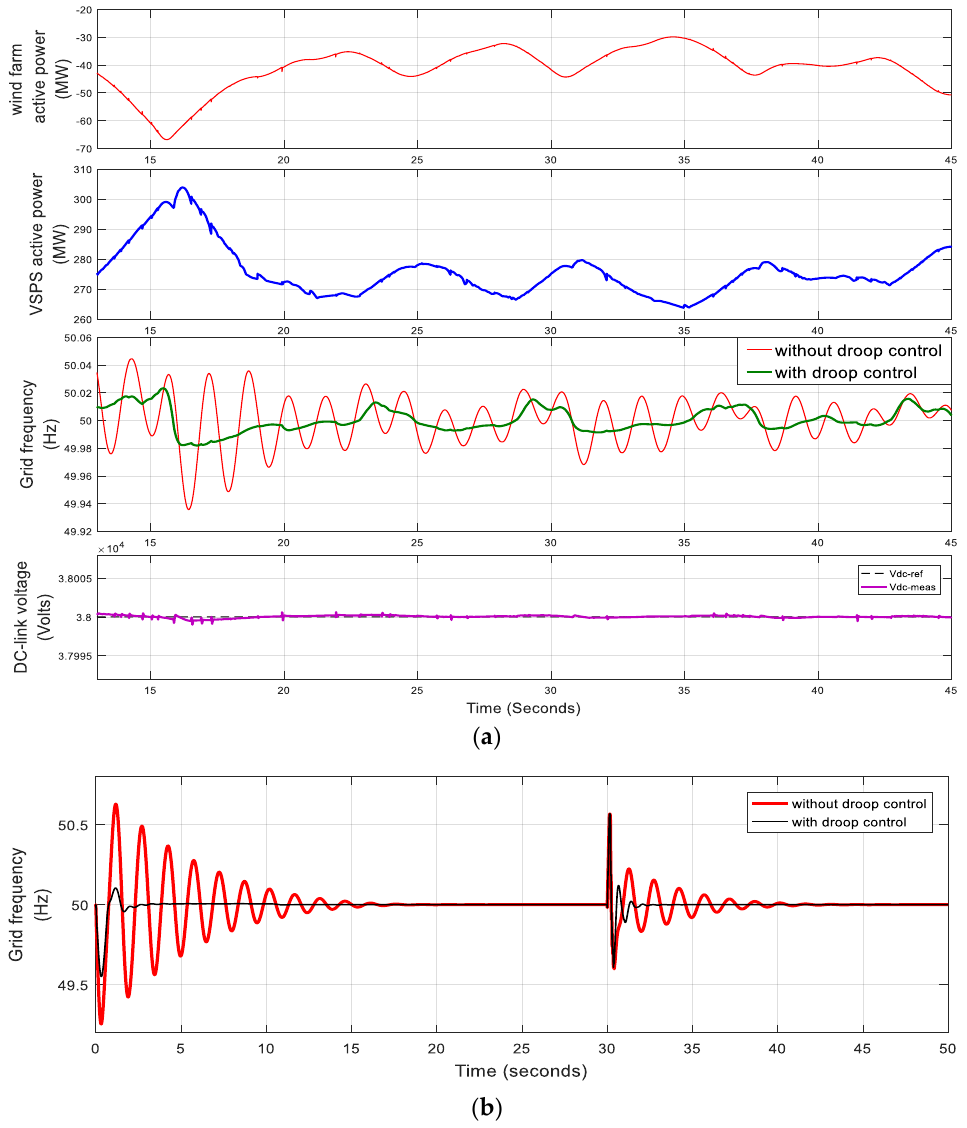
Figure 14. Evolution of the network in grid frequency response comparing the VSPS active power control with and without droop control and the DC link voltage as well: ( a ) while the wind farm power fluctuation exists in the grid; ( b ) during the start-up transient and three phase fault.